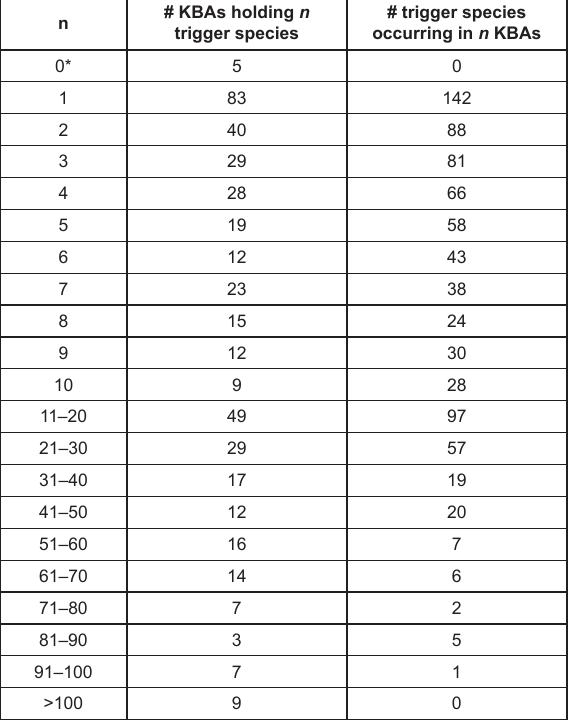
Table 4. Frequency distributions of the number of trigger species per KBA, and the number of KBAs per trigger